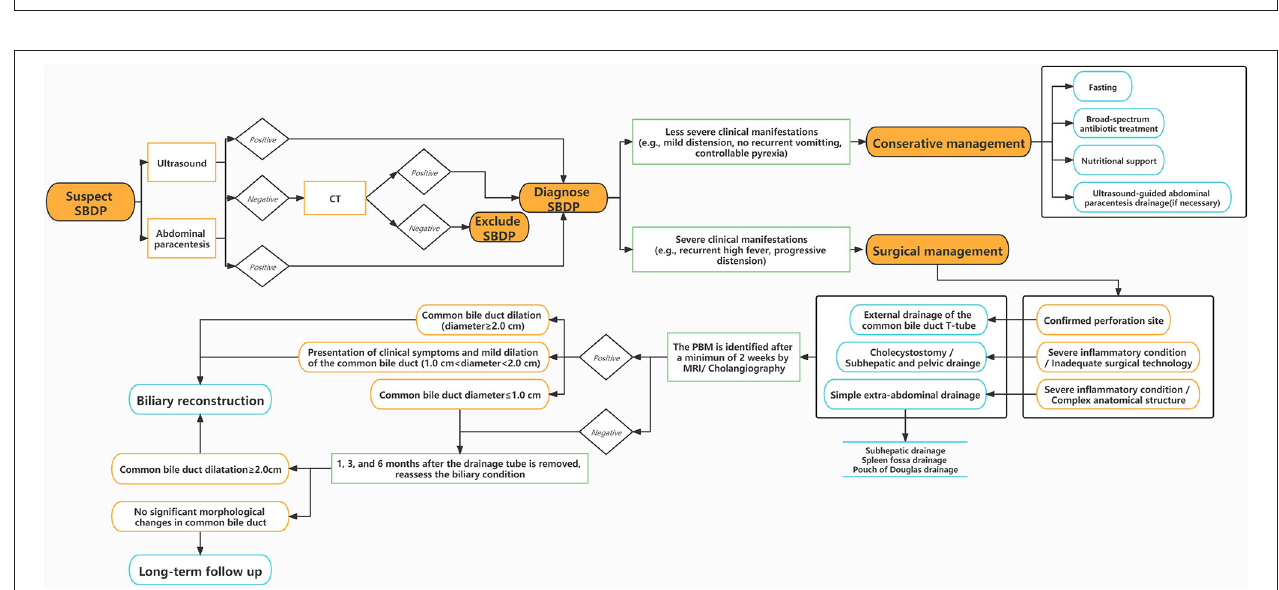
FIGURE 2 | Theories of the mechanisms of SBDP.